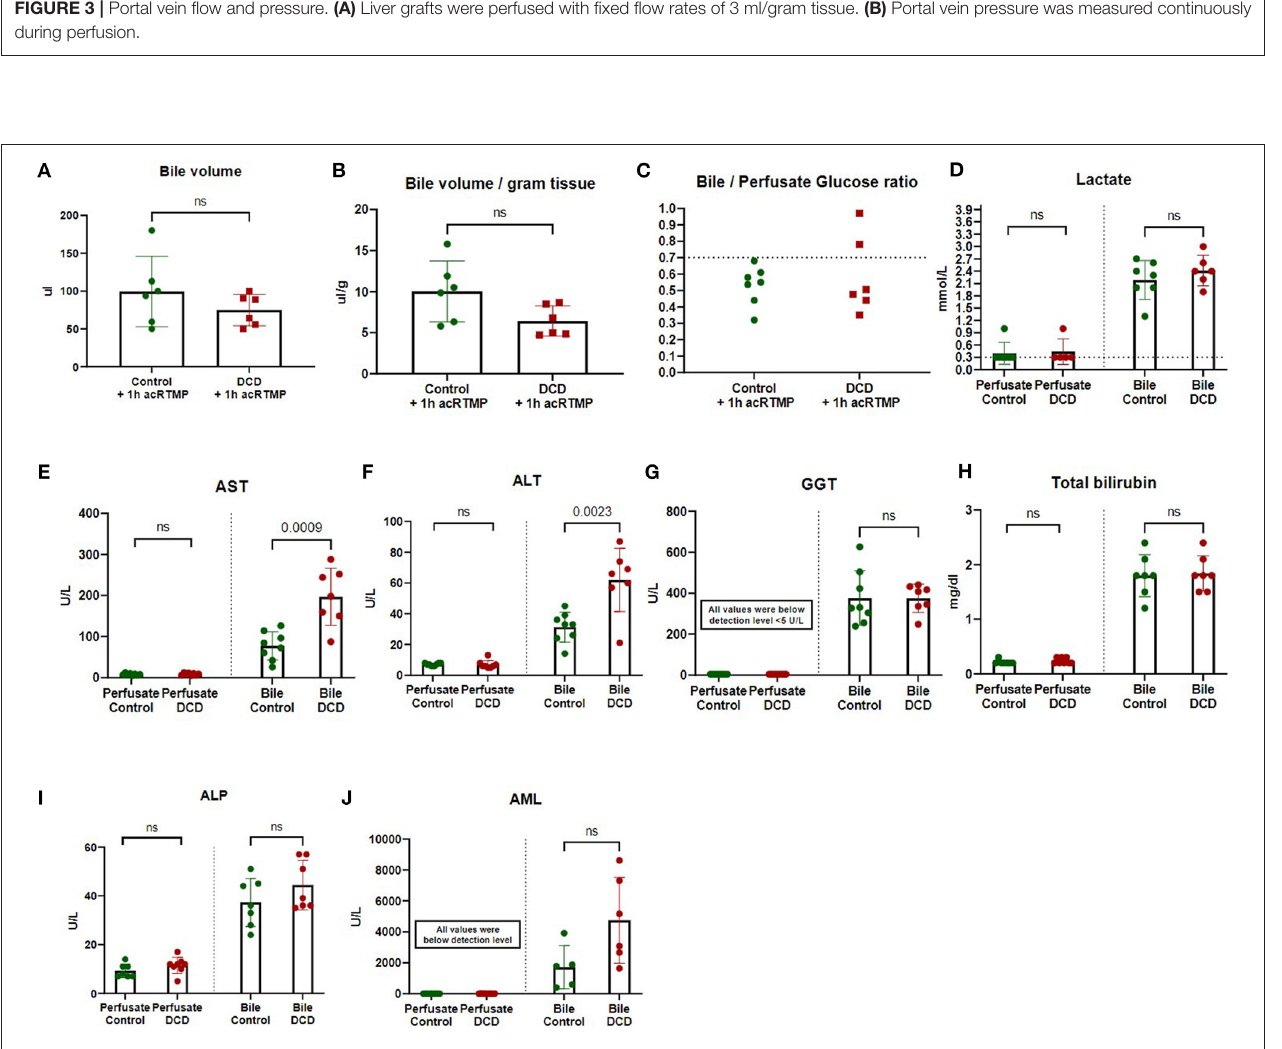
FIGURE 4 | (A-J) Two-compartment evaluation for liver graft assessment during machine perfusion. Biochemical parameters were measured and compared in biliary vs. perfusate compartments.